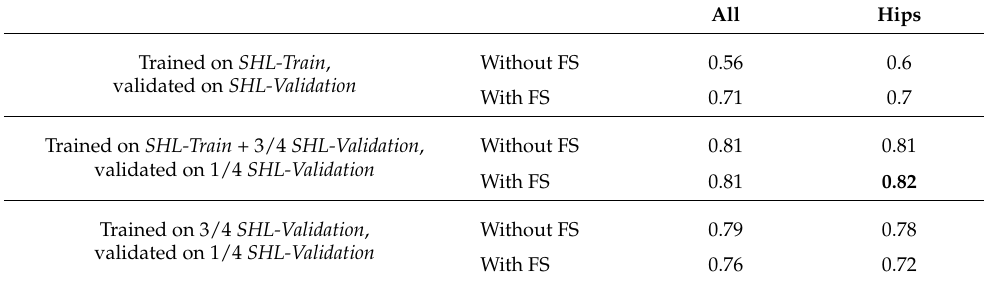
Table 6. Comparison of the F1 scores obtained using different combinations of training data for 2020. For each training combination, we tested whether the adaptation of the features to the hips location improves the results. The columns All and hips indicate which data were used for training. The All column includes bag , torso , hand and hips . All the results presented in this table were obtained using only the instances from the hips location when